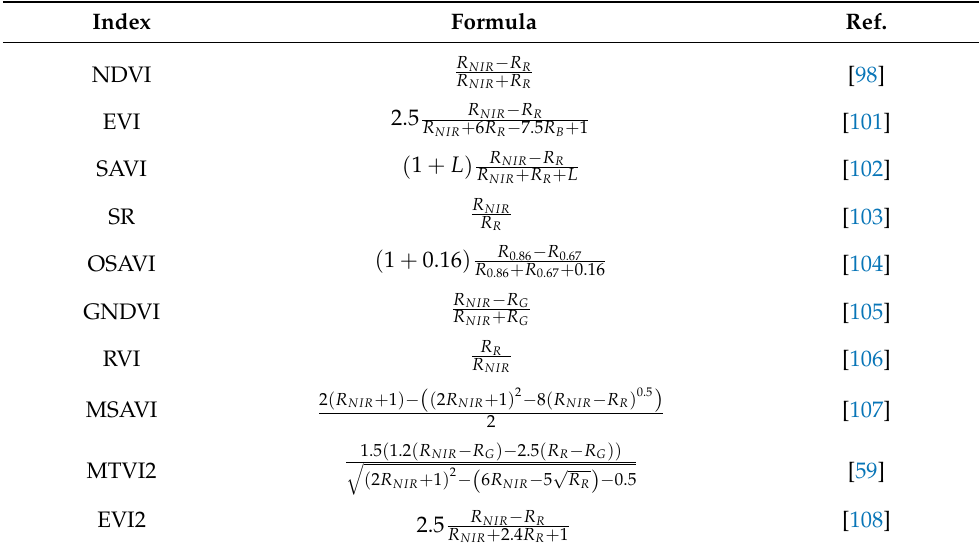
Table 3. The formula of the top 10